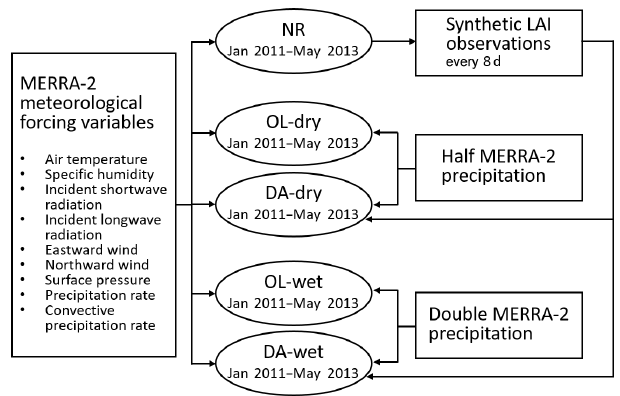
Figure 2. Schematic diagram of the OSSE design.